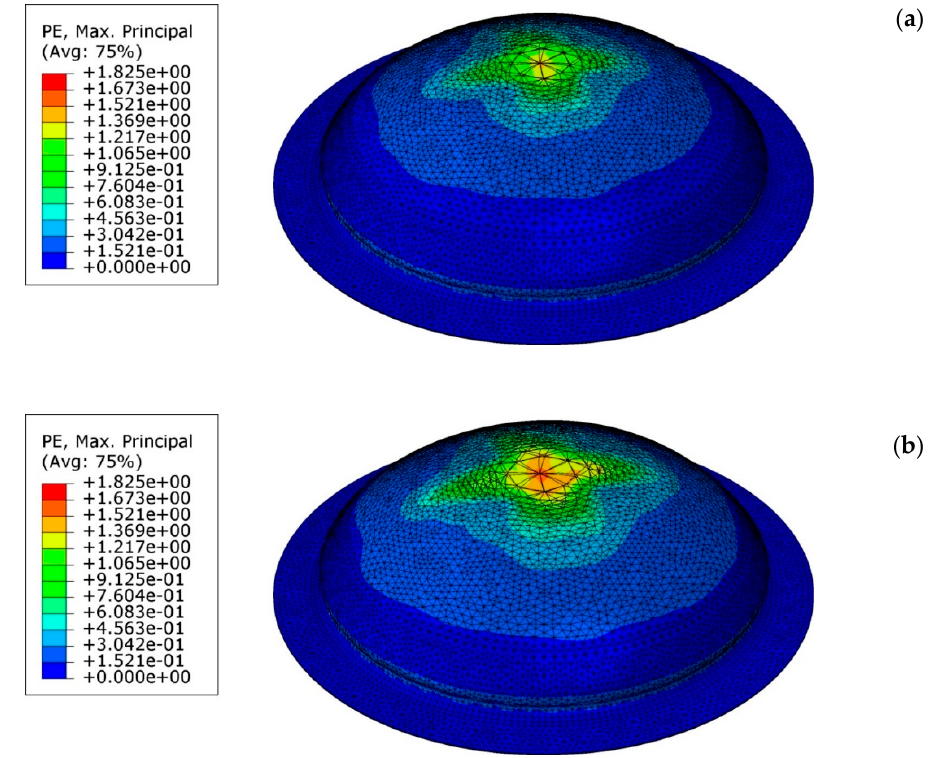
Figure 8. Two representative cloud maps of the plastic deformation distributions taken from successive loading at 300 K. ( a ) F max = 1500 N and ( b ) F max = 2943 N.